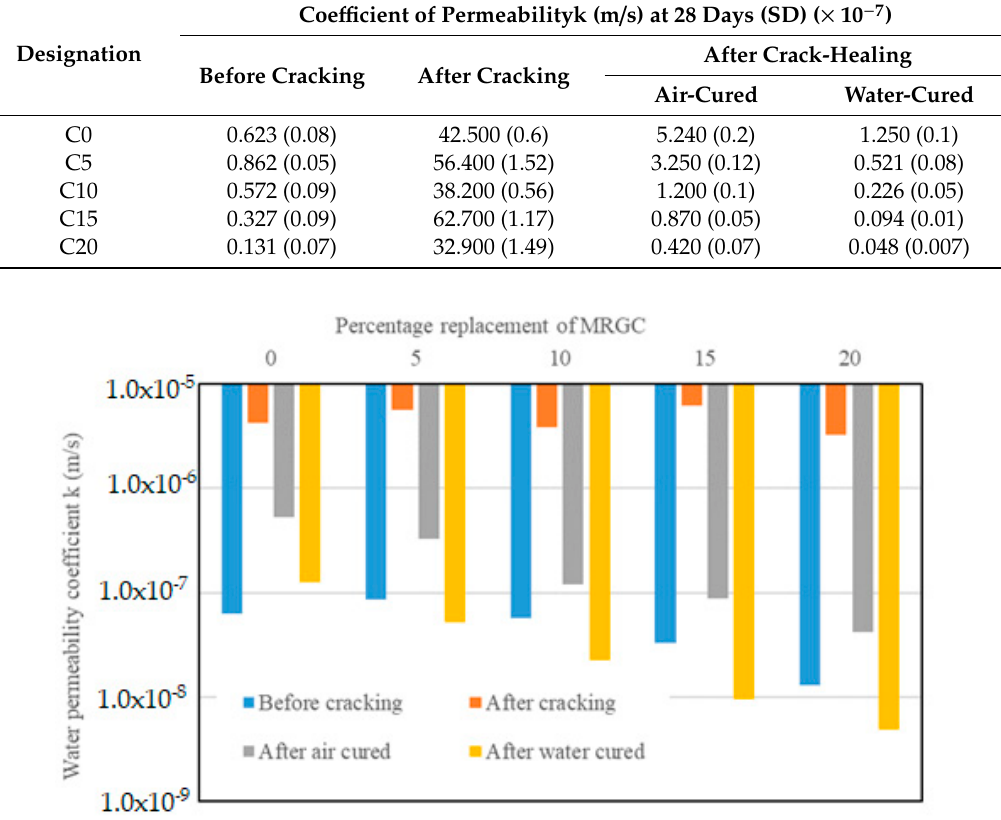
Figure 7. E ff ect of MRGC content and curing mechanisms on water permeability coe ffi cient Figure 7. Effect of MRGC content and curing mechanisms on water permeability coefficient k.